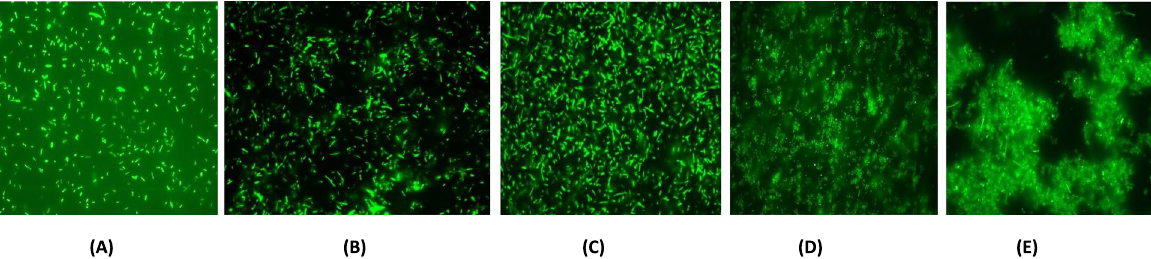
Fig. 13 SYTO 9-PI staining of expression host, E.coli after IPTG induction of negative control: A 0 th h, B 1 st h, C 2 nd h, D 4 th h, and E 6 th h